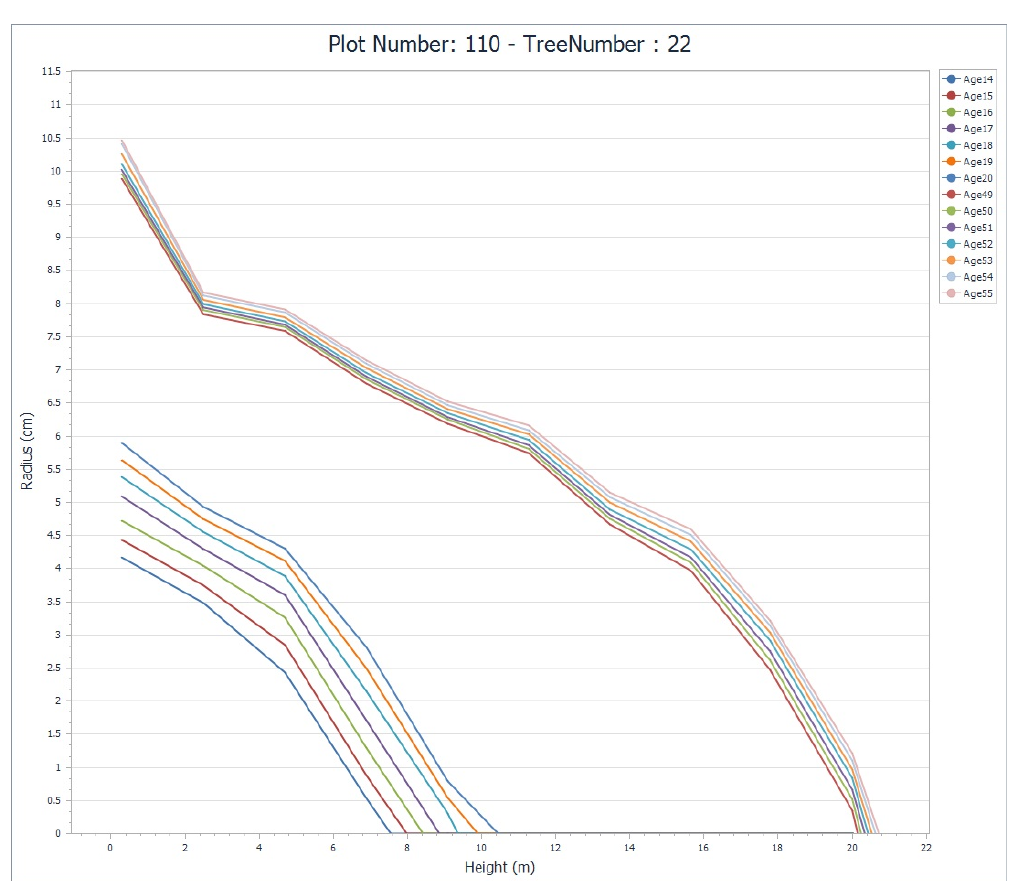
Figure 6. Selected growth layer profiles for the example tree illustrating the longitudinal distribution of radial annual increment widths with increasing stem height, for the three years prior to the 1st and 2nd thinnings (1959–1961 and 1994–1996, respectively), the year of thinning treatments (1962 and 1997), the following three years after the 1st and 2nd thinnings (1963–1965 and 1998–2000, respectively).